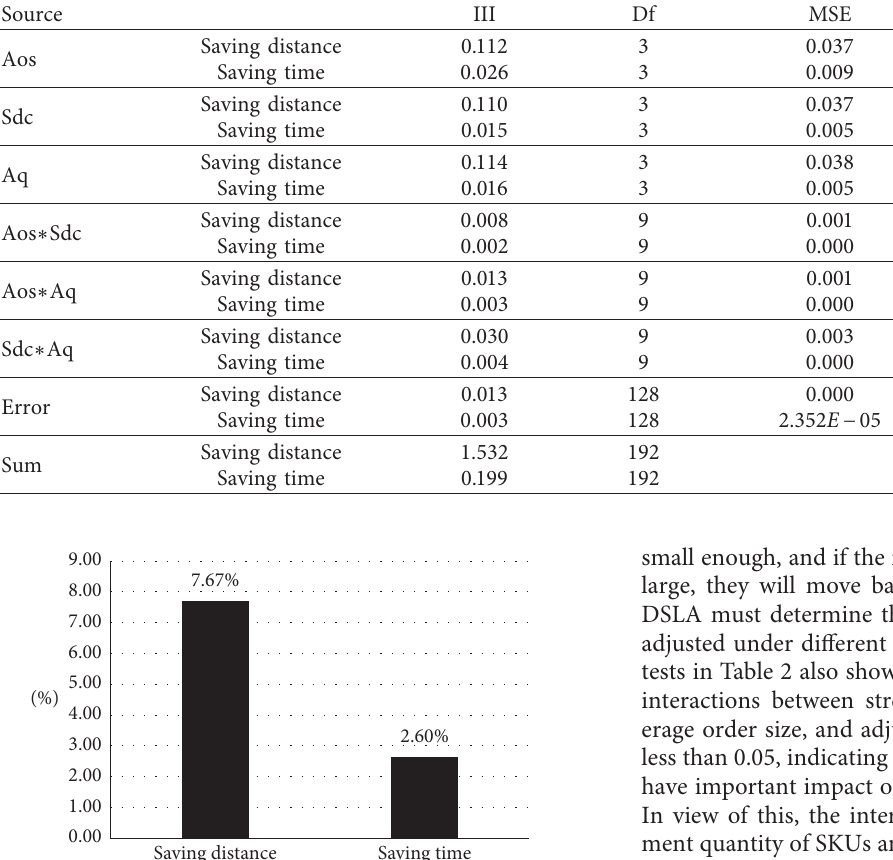
Figure 5: General optimization effect of